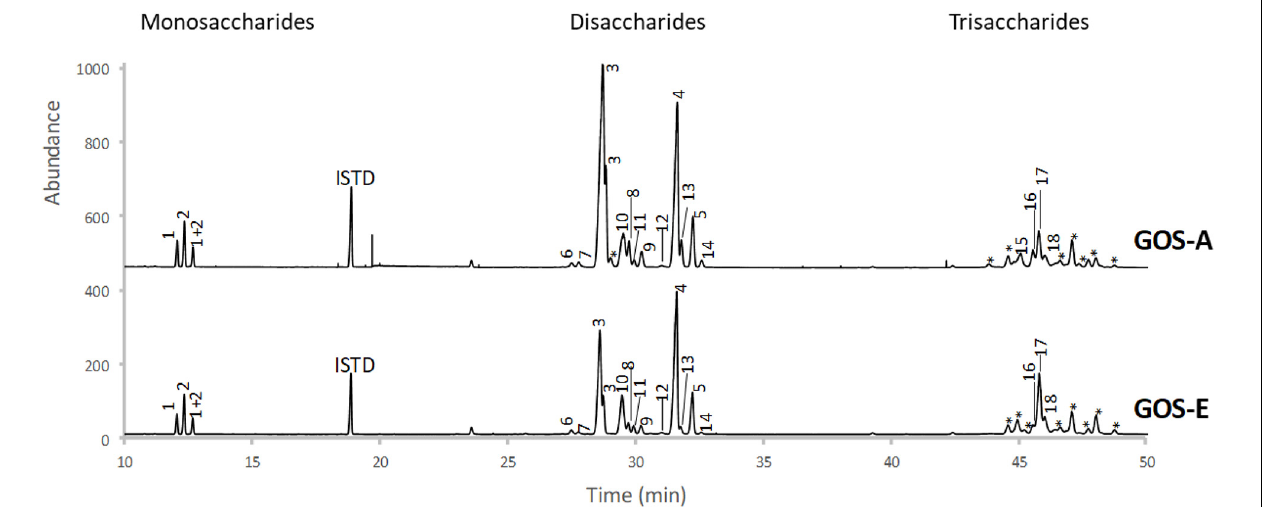
FIGURE 1 | GC-FID profiles of trimethylsilyl oximes of mono-, di-, and trisaccharides from GOS-A and GOS-E. Peak numbers correspond to structures identified in Table 3